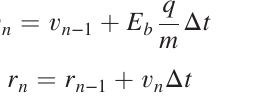
and related gas density increment in c